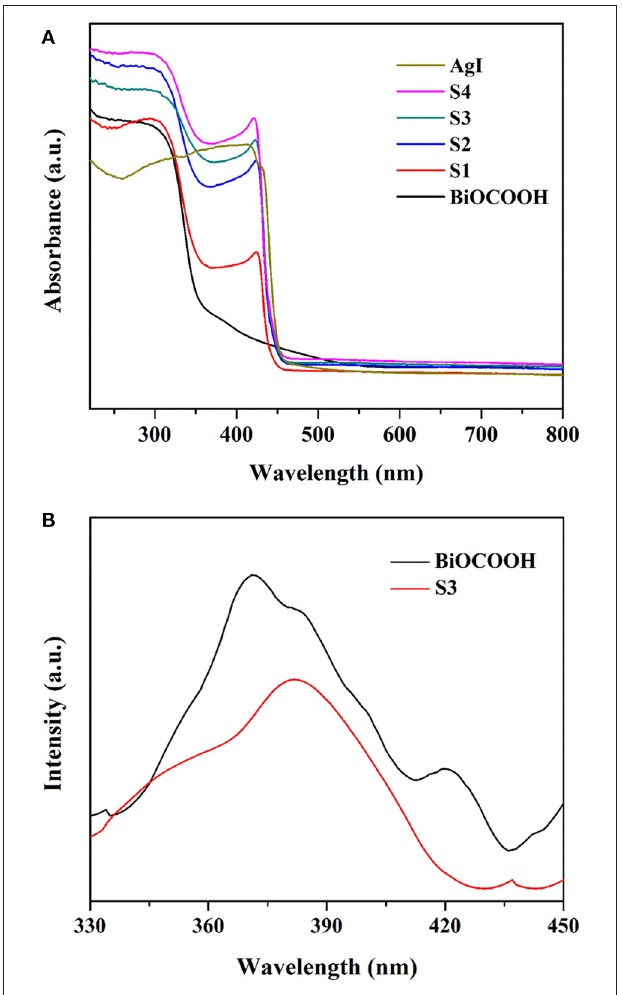
FIGURE 4 | (A) UV–Vis DRS of bare BiOCOOH, AgI, and AgI/BiOCOOH heterojunctions (S1, S2, S3, and S4). (B) PL spectra of pristine BiOCOOH and S3 with an excitation wavelength of 300nm.